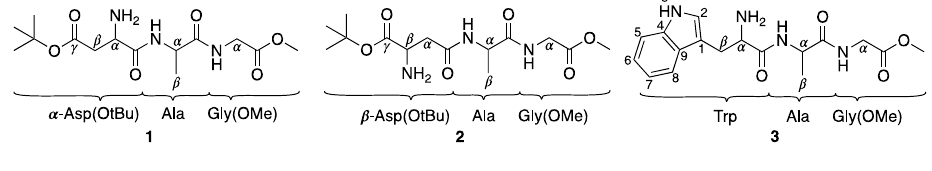
Figure 2. Tripeptide ligands 1 – 3